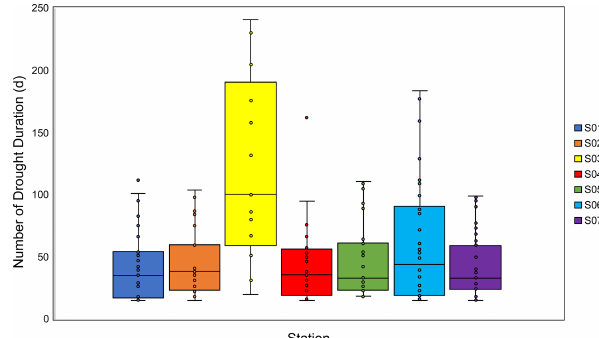
Figure 8. Length of drought duration